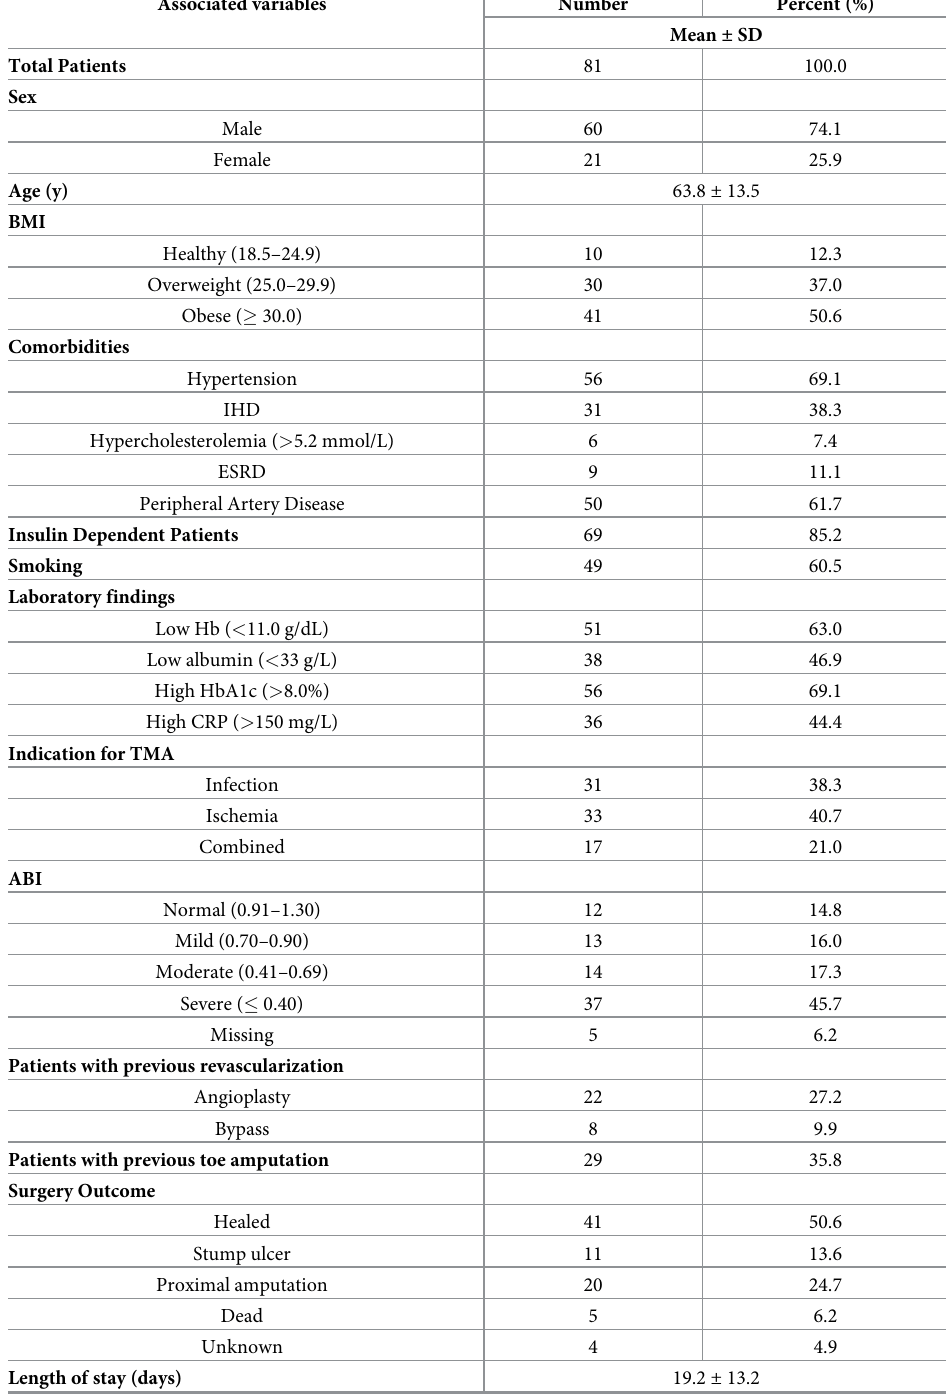
Table 1. Characteristics and clinical presentations of diabetic patients who underwent transmetatarsal amputa- tion